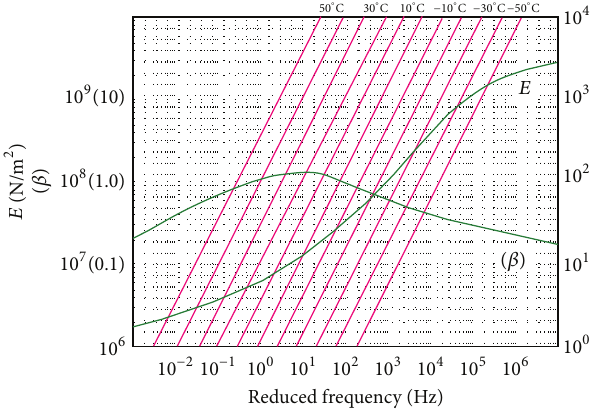
Figure 6: Damping VER-IPN property